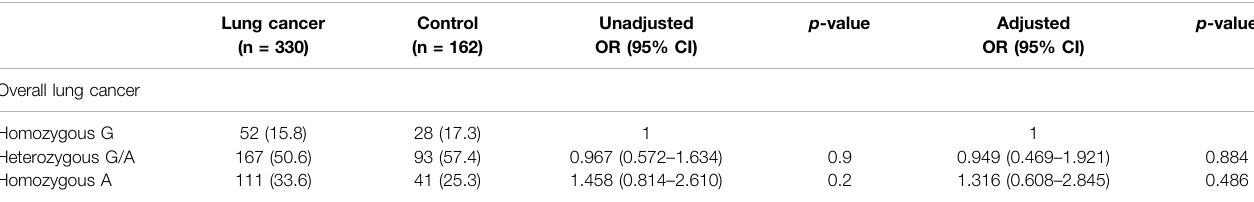
TABLE 3 | The genotype distribution of COX-2 – 1195G/A in patients with lung cancer and control